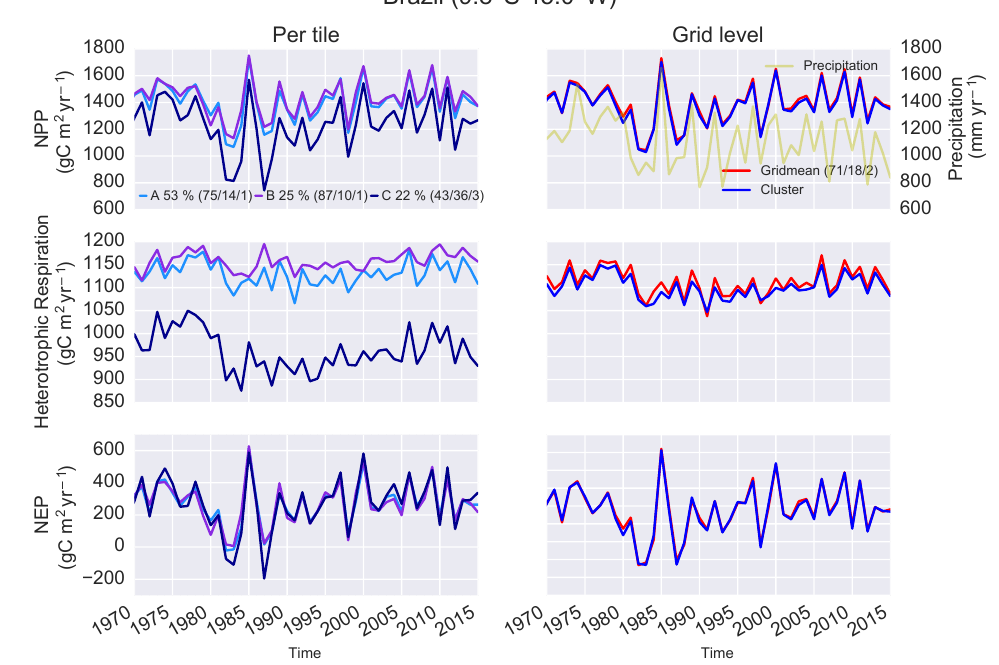
Figure 5. The same as Fig. 4 for a grid cell in Brazil (same cell as Fig.